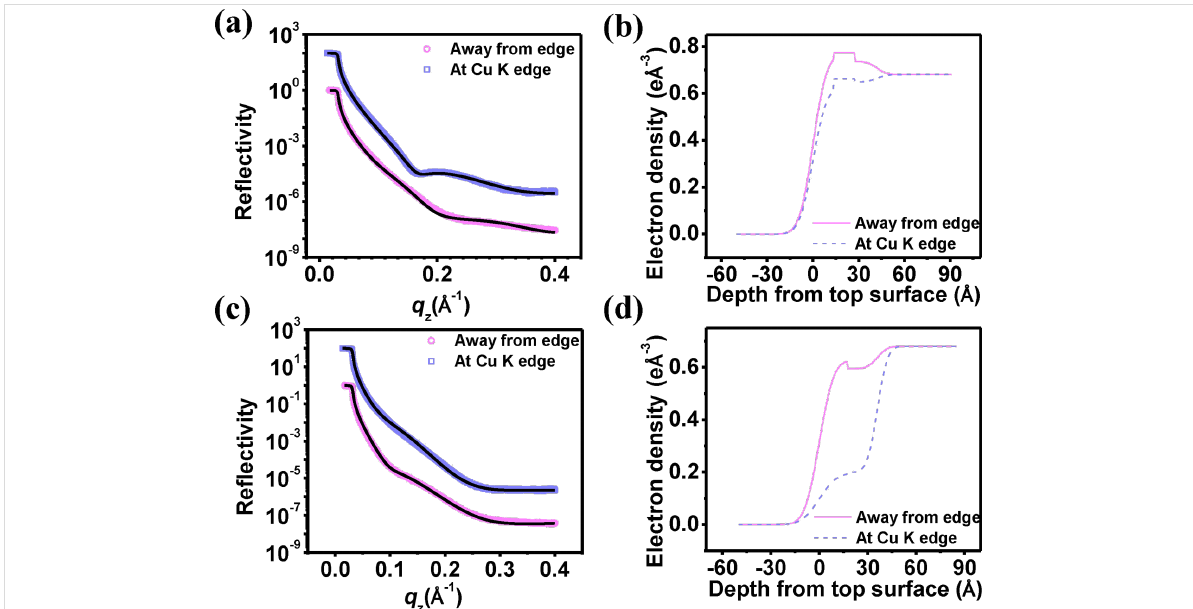
Figure 3: X-ray reflectivity data at and away from Cu absorption edge (up shifted for clarity). Symbols: experimental data points; line: fit with DWBA formalism. (a) Reflectivity profiles of Cu(II)–piroxicam–DNA film, (b) corresponding EDPs. (c) Reflectivity profiles of Cu(II)–piroxicam–DNA–buffer film, (d) corresponding